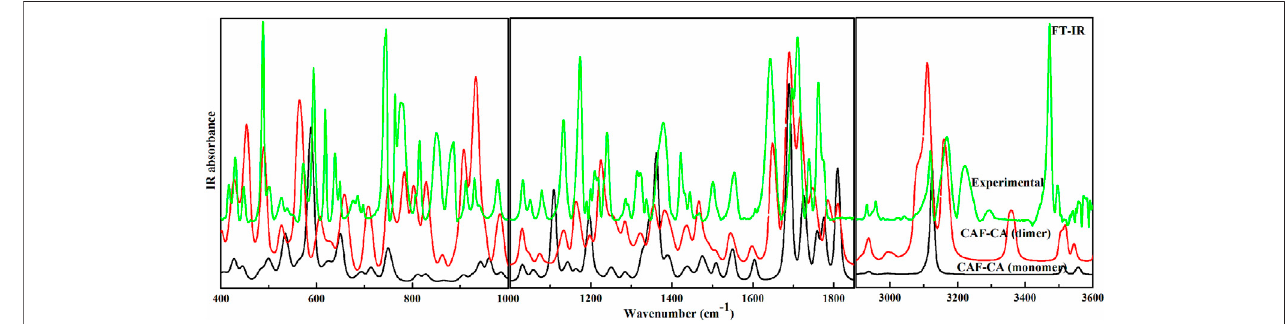
FIGURE 3 | Experimental and calculated (scaled) IR absorbance spectra of monomer and dimer model of cocrystal in the region 400 – 1,000 cm − 1 , 1,001 – 1850 cm − 1 and 2,900 – 3,600 cm − 1 .